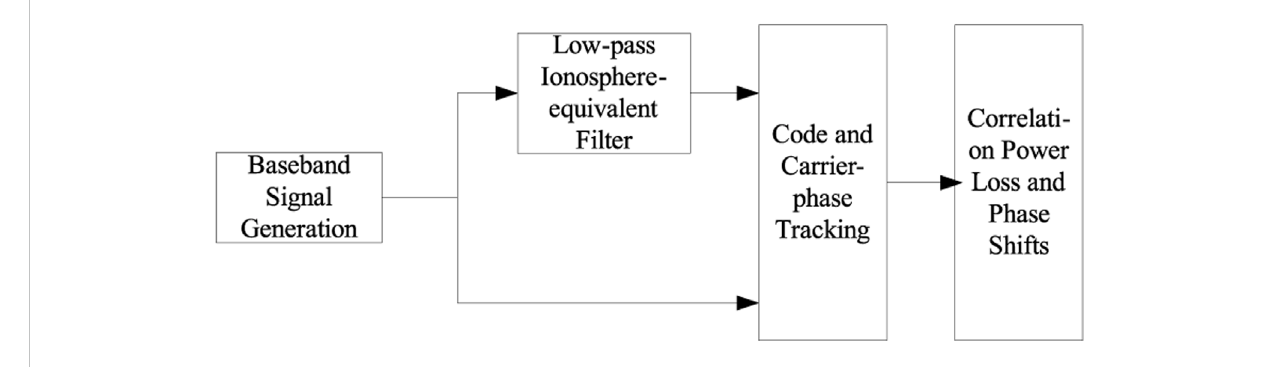
FIGURE 4 Schematic of computer simulation.